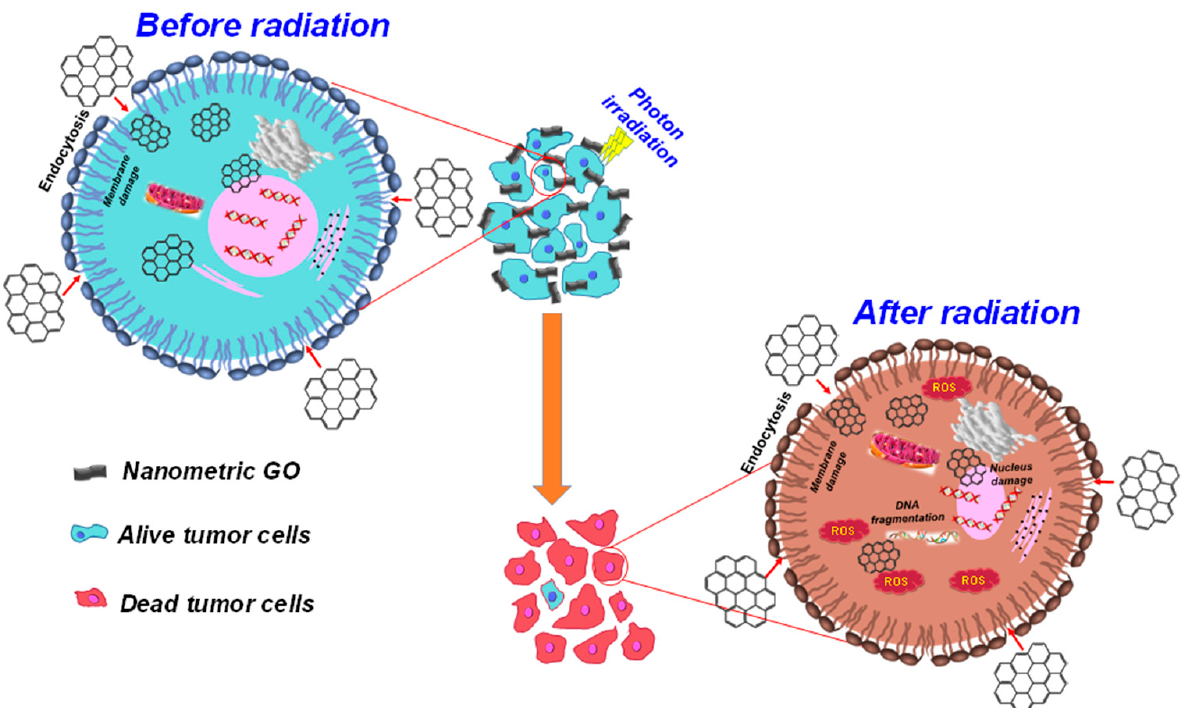
Figure 1. Schematic illustration of GO interaction with cancer cells and the photon irradiation effects of GO.